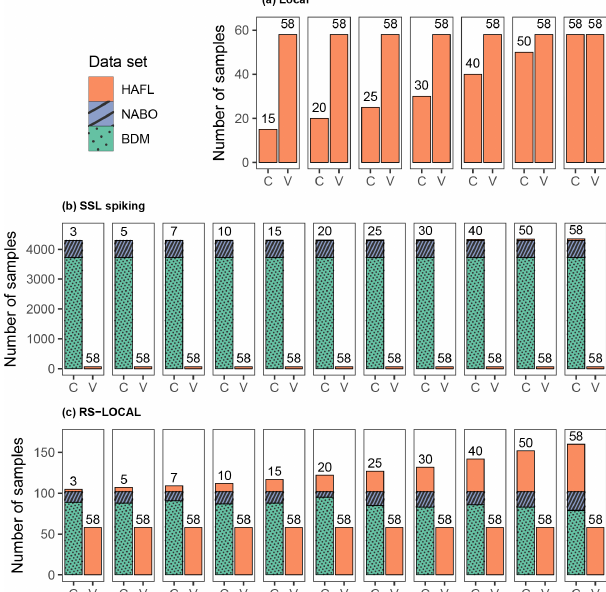
Figure 2. The number of samples used in each calibration (C) and validation (V) scheme using HAFL, BDM and NABO data sets for (a) local, (b) SSL spiking and (c) RS-LOCAL approaches. The same 58 local HAFL samples never used in calibration were used to validate each modeling approach and iteration. Note different the scales on the y